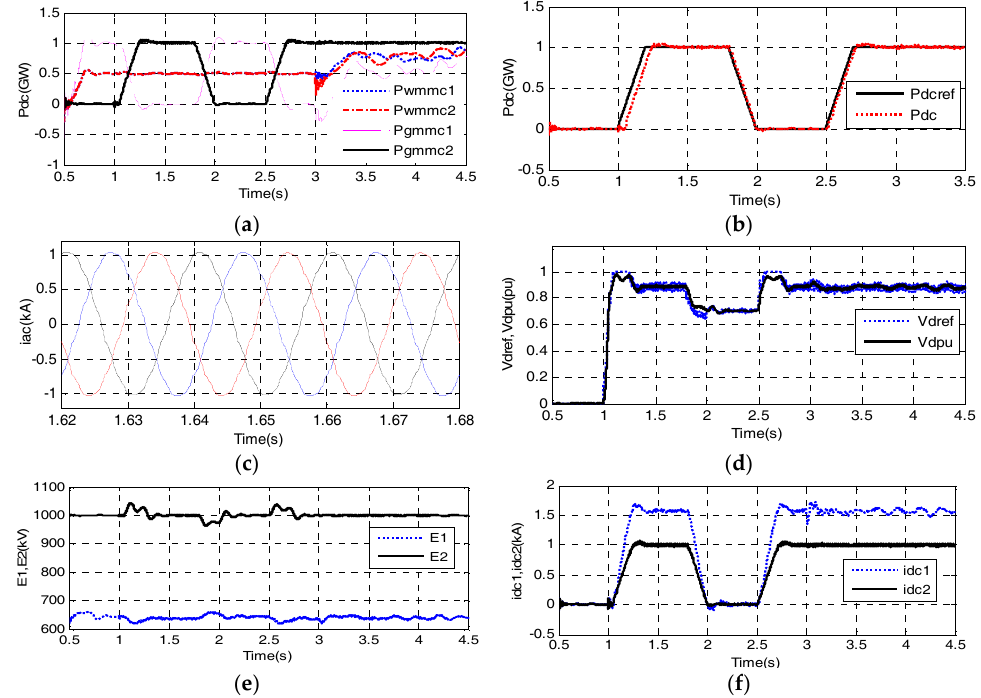
Figure 7. Simulation of integrating wind power through UUDAT. ( a ) DC power of WMMC1, WMMC2, MMC1 and GMMC2; ( b ) DC power reference and DC power of UUDAT; ( c ) Output AC current of MMC2 at full DC power; ( d ) Output AC voltage of MMC2 at zero DC power; ( e ) DC voltages at higher voltage side and lower voltage side; ( f ) DC currents at higher voltage side and lower voltage side.